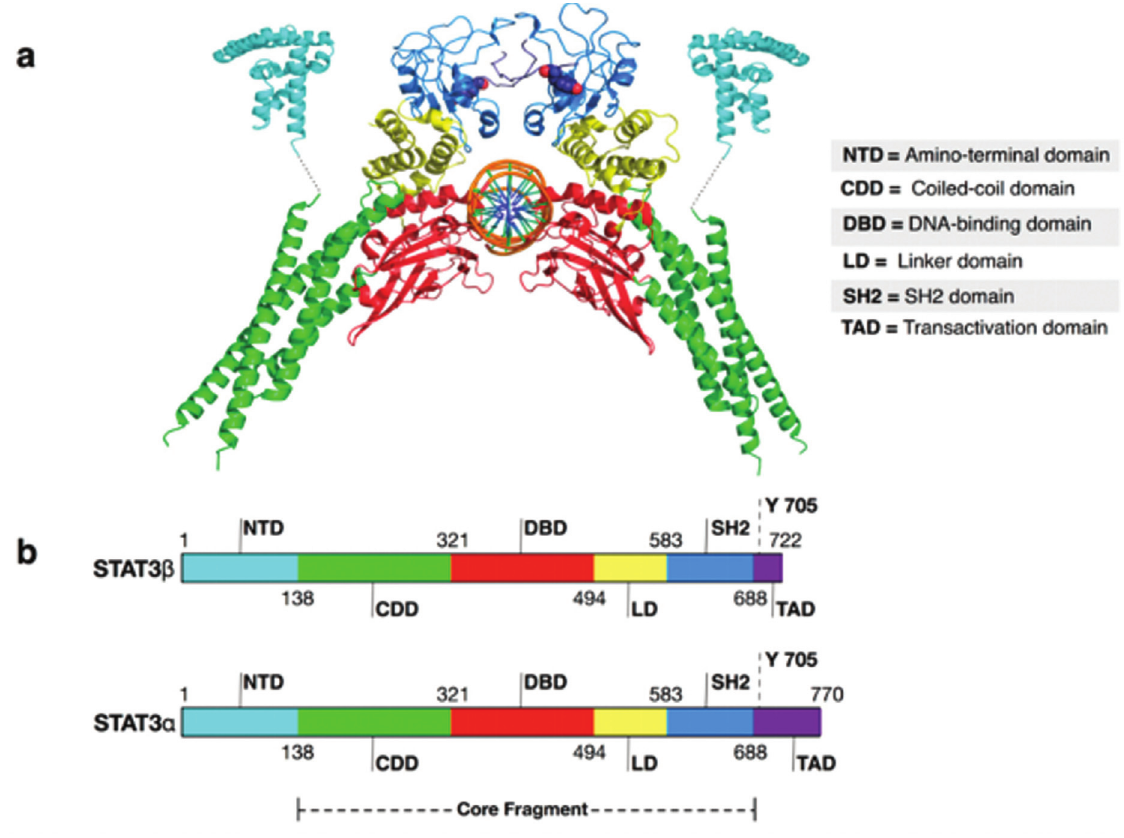
Figure 3 - Three dimensional structure of STAT 3 indicating its active and inhibitory sites. (a) 4Z1A PDB hit of STAT 3. (b) Different domains of STAT 3 present in loops of STAT